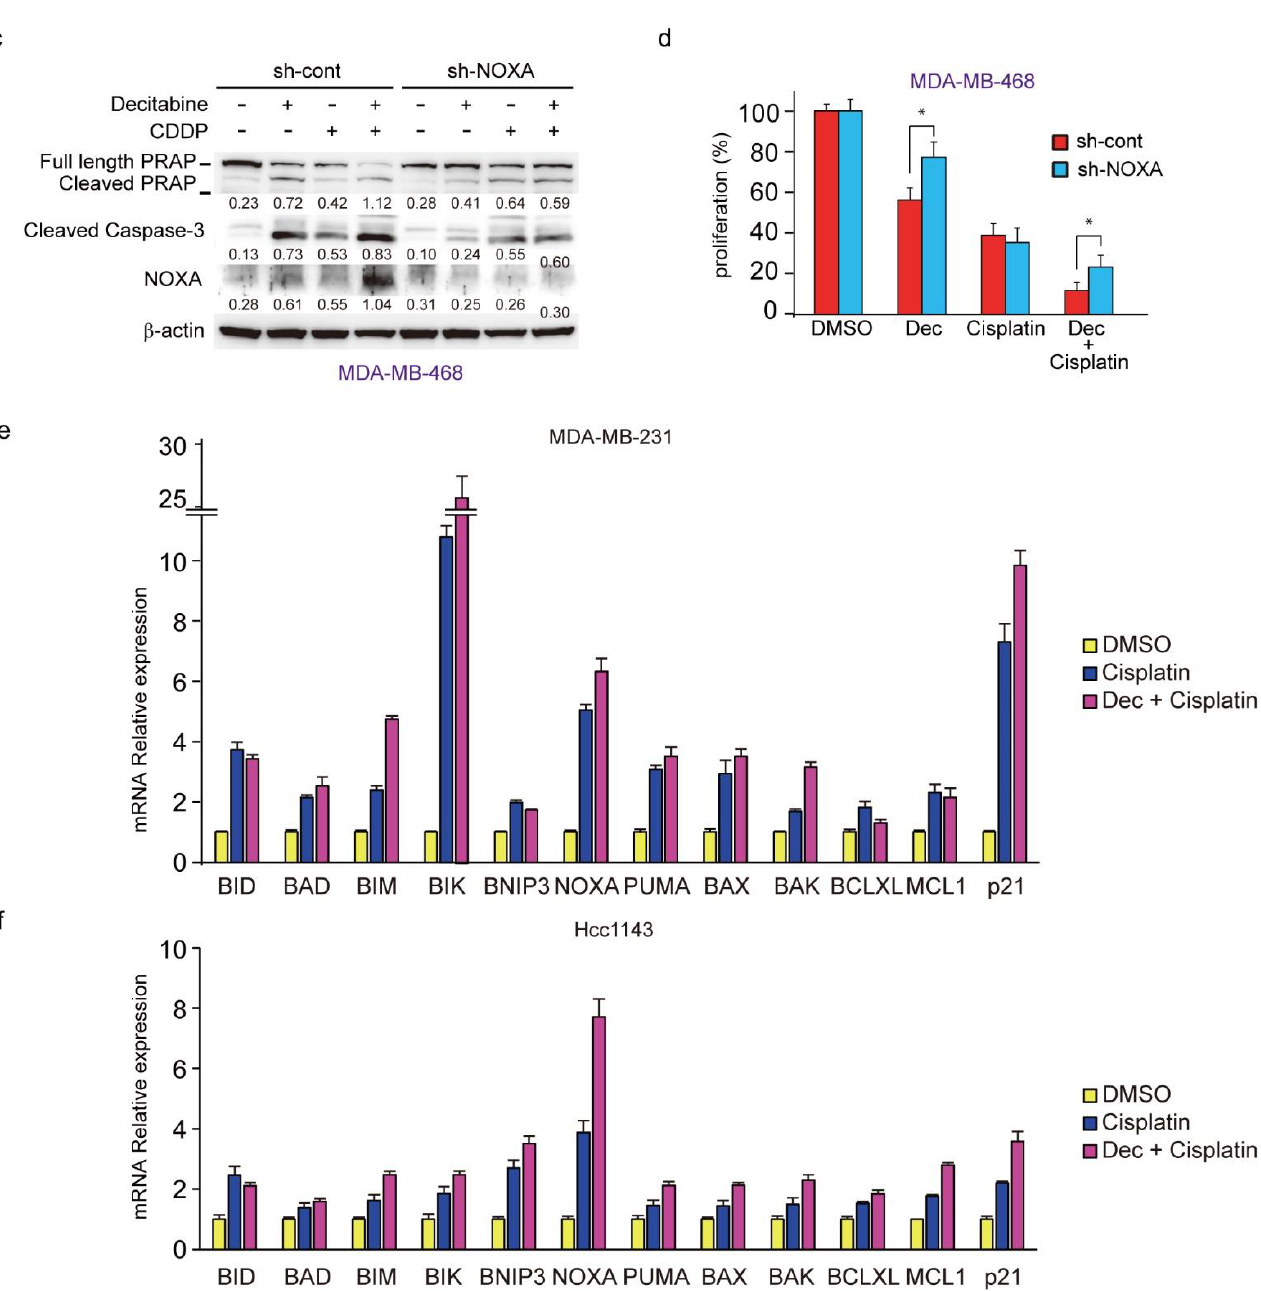
Figure 8. Decitabine enhances the cisplatin-induced mRNA levels of NOXA and other BH3-only proteins. ( a,b ) MDA-MB468 and HCC38 cells were treated with DMSO (1 μg /mL), decitabine (500 nM), and/or cisplatin (20 μM). After treatment for 72 h, the indicated mRNA levels in MBA-MB-468 ( a ) and HCC38 ( b ) cells were measured by quantitative real-time PCR. ( c , d ) MBA-MB-468 cells stably expressing shRNA-targeting NOXA (sh-NOXA) or sh-control were treated with DMSO (1 μg /mL), decitabine (500 nM), and/or cisplatin (20 μM). After treatment for 72 h, equal amounts of total cell lysate were subjected to immunoblot analysis with the indicated antibodies ( c ) and cell proliferation was measured by CCK-8 analysis ( d ). Numbers below blots represent the relative band intensity of each protein normalized to the signal intensity of β -actin. The uncropped immunoblot images can be found in Figure S7. ( e ) MDA-MB231 and HCC1143 cells were treated with DMSO (1 μg /mL), decitabine (500 nM), and/or cisplatin (20 μM). After treatment for 72 h, the indicated mRNA levels in MBA-MB-231 (e) and HCC1143 ( f ) cells were measured by quantitative real-time PCR. Error bars indicate SD ( n = 3). Data are expressed as the mean ± SD of triplicate experiments. *, p < 0.05.